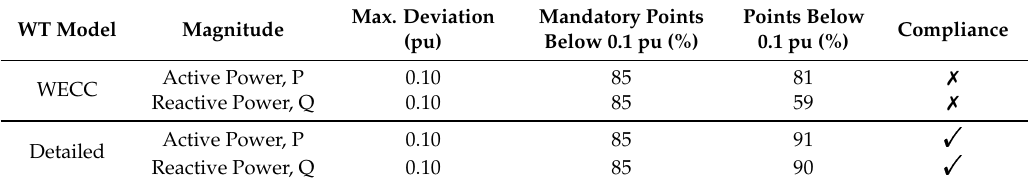
Table 1. Verification of the procedure for verification, validation, and certification (PVVC) validation criteria applied to the WECC and detailed WT models at the testing point, operating at full load conditions: 20 kV, measurement point at HV